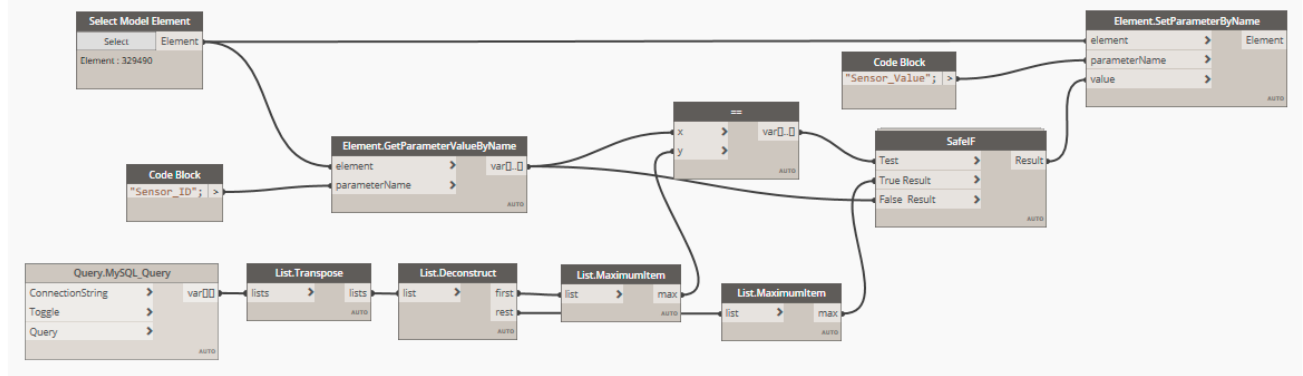
Figure 11. Dynamo nodes of writing information acquired to sensor attribute values. (3) Set the periodic running interval of Dynamo.